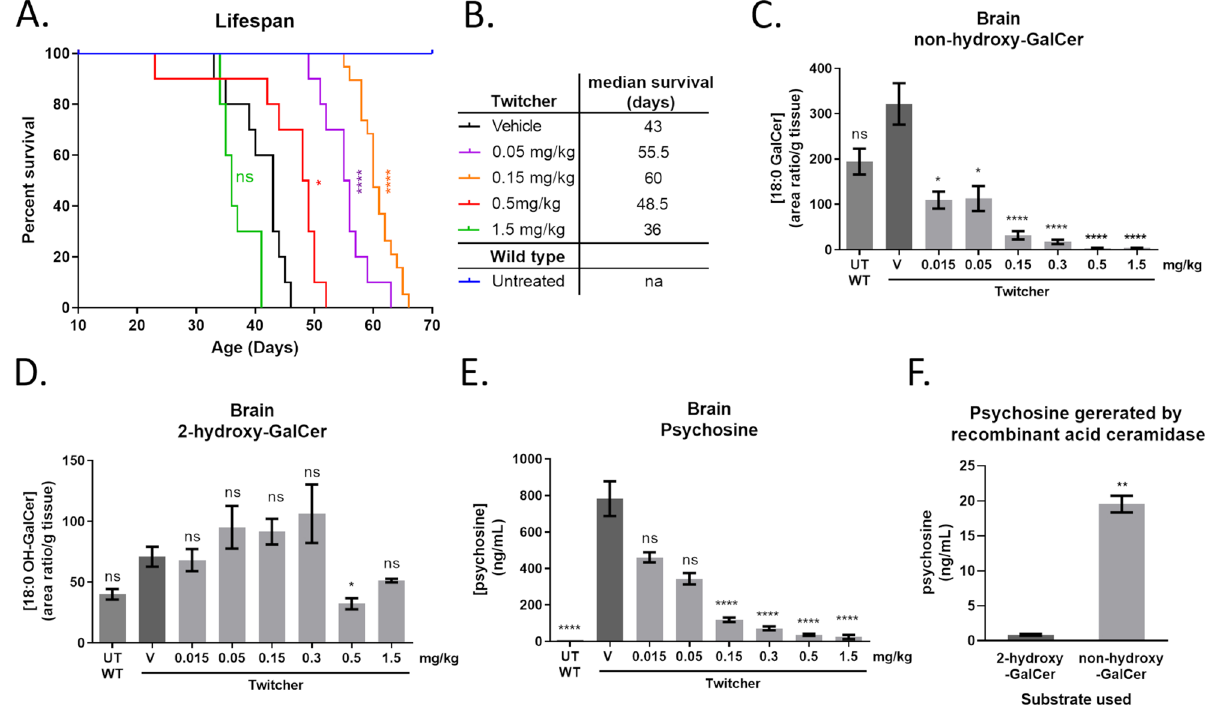
Figure 4. CGT inhibition extends survival and reduces psychosine levels in a KD mouse model. Survival curves of Twitcher mice treated with S202 injected IP three times per week starting on PDN3 ( A ) and median days of survival ( B ). Untreated wild-type (UT WT) mice survived while vehicle treated Twitcher mice (vehicle) had a median survival of 43 days. S202-treated Twitcher mice survived longer except at the highest dose tested (1.5 mg/kg). Effect of S202 treatment on non-hydroxy-GalCer ( C ) and 2-hydroxy-GalCer in brain homogenates from mice treated from PND3-PND28 ( D ). Psychosine reduction in these brains correlates with reduction of non-hydroxy-GalCer ( E ) (n = 5–8, C – E ). Quantification of psychosine generated by recombinant acid ceramidase incubated with either purified 2-hydroxy-GalCer or non-hydroxy-GalCer substrates (n = 2 per condition, F